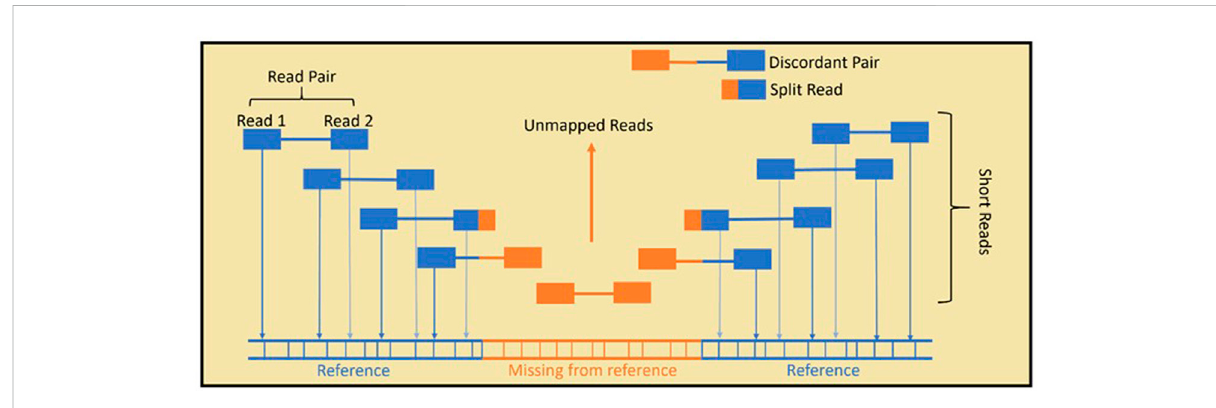
FIGURE 2 InstandardIlluminapaired-endSR-WGS,theDNAsampleis fi rstshearedintosmallfragments.Then, bothendsofthefragment aresequenced, giving paired reads. Read mapping is achieved by aligning the reads to a reference genome. HERVs that are present in the sample but not the reference, cannot be aligned fully and remain largely unmapped, which means they are often overlooked in genome analysis.